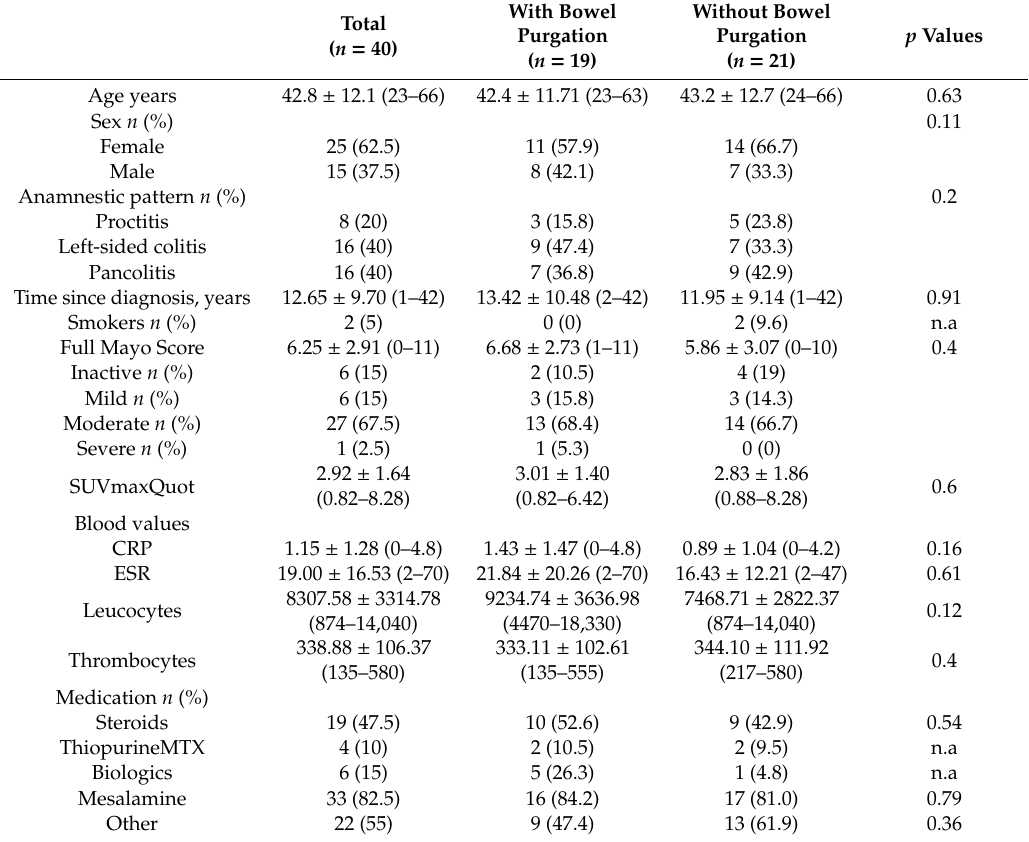
Table 1. Sociodemographic and clinical characteristics (mean ± standard deviation (range)).